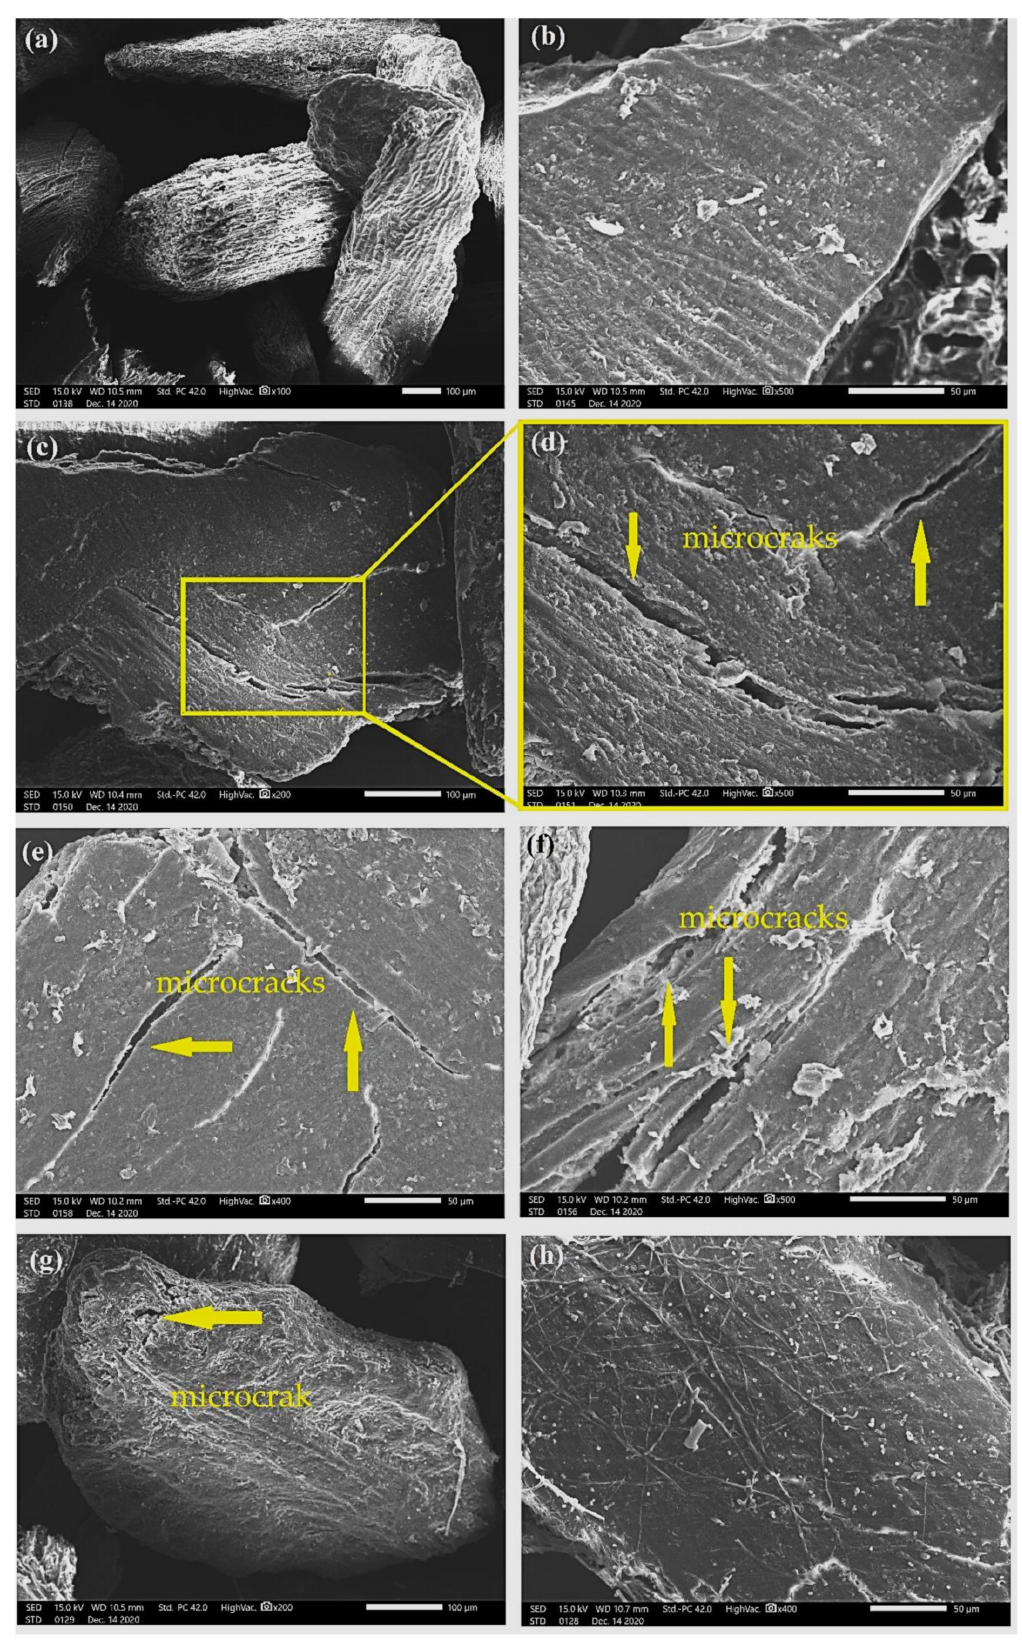
Figure 8. Photomicrographs of CHFW after BIO 24 ( a , b ); BIO 48 ( c , d ); BIO 72 ( e , f ); and BIO 96 ( g , h )